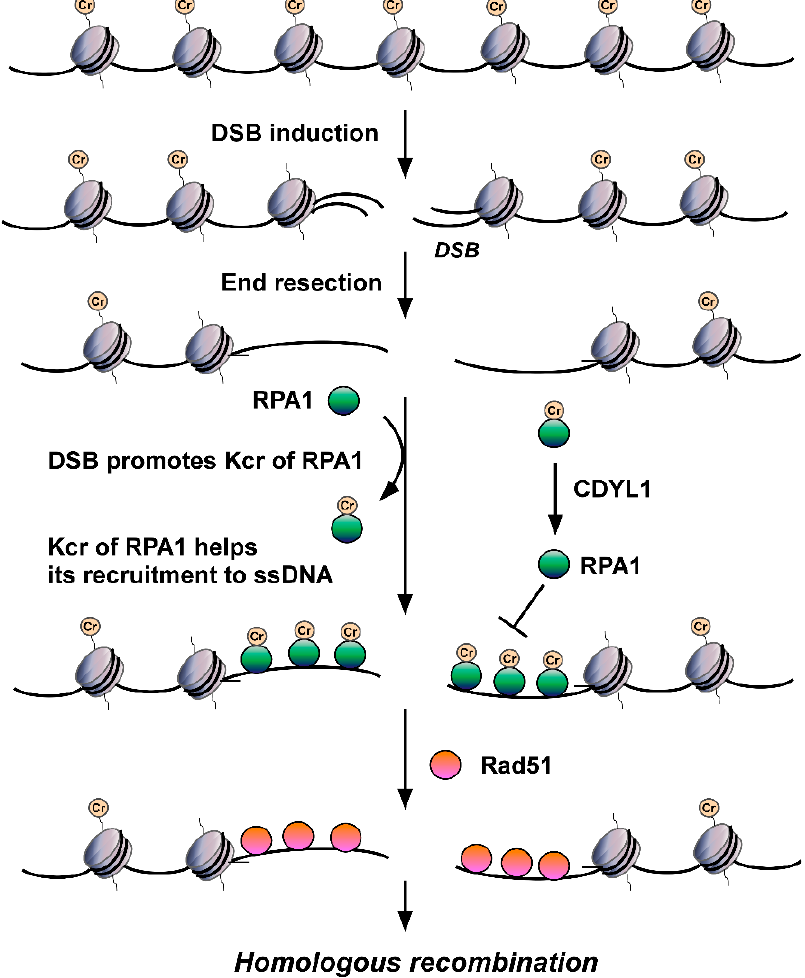
Figure 2. The roles of RPA Kcr in DSB repair. DSB injury promotes Kcr of RPA1. Kcr can increase the affinity of RPA for ssDNA, facilitate its recruitment to ssDNA generated by DSB end resection, enhance its interactions with major HR factors, such as RAD51, and promote HR-mediated DSB repair.